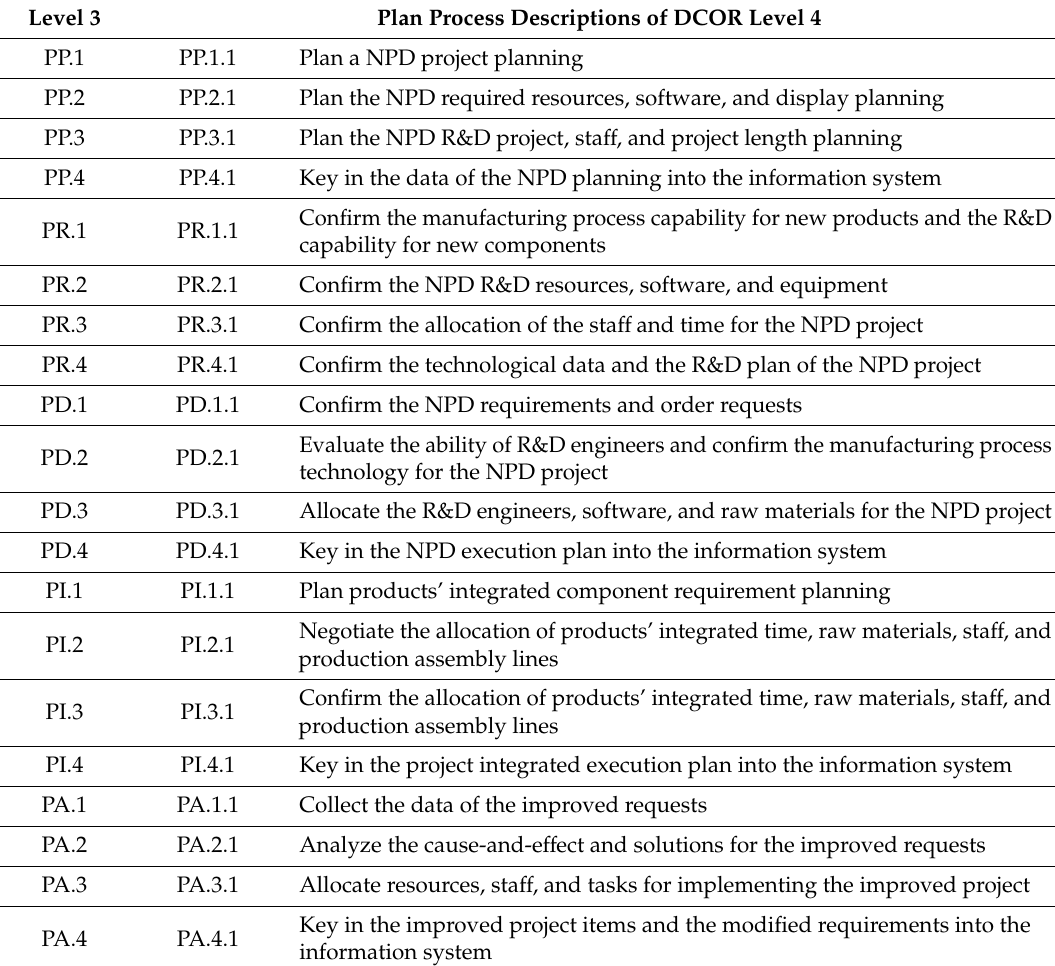
Table 1. Plan process of DCOR Level